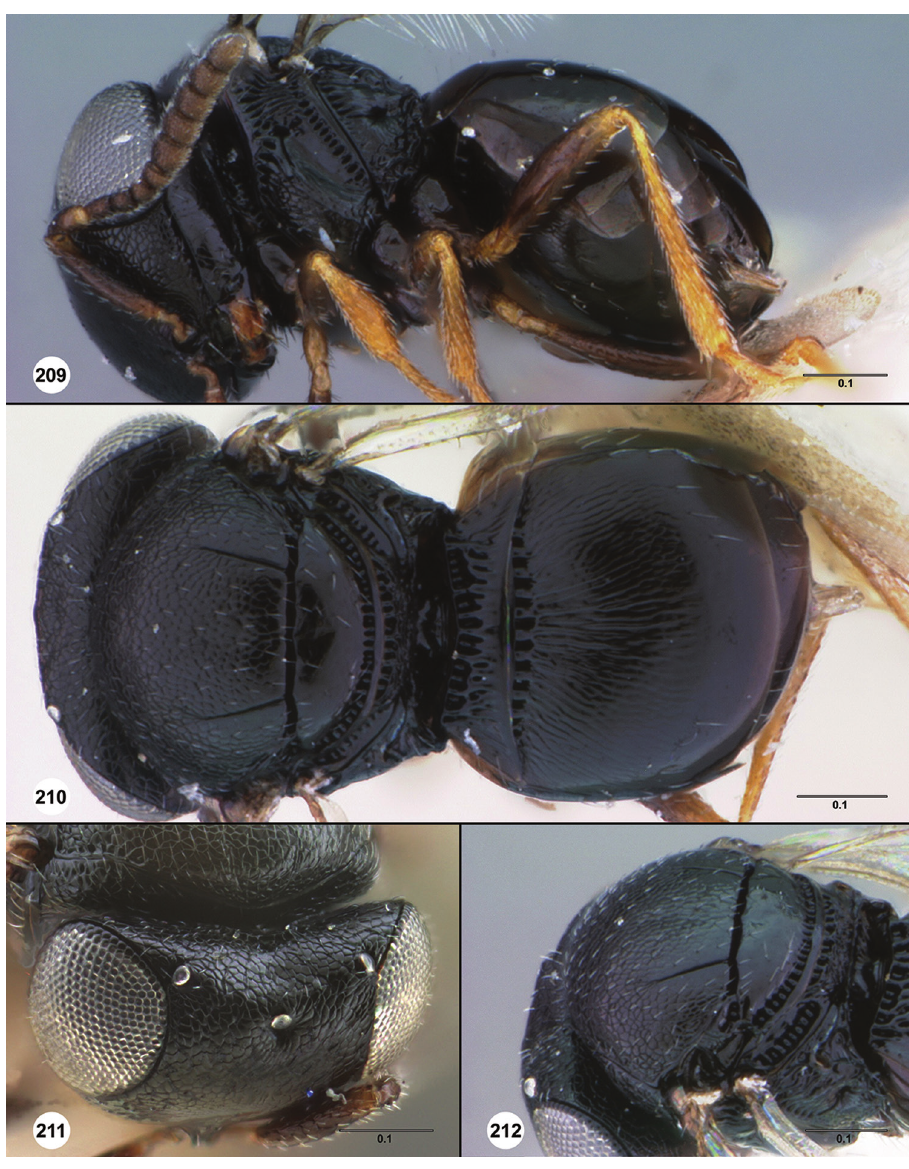
sculptured. Macrosculpture of lateral frons: absent. OOL: separated by less than one ocellar diameter. Hyperoccipital carina: absent. Macrosculpture of posterior vertex: absent. Microsculpture on posterior vertex along occipital carina: present. Anterior margin of occipital carina: finely crenulate to